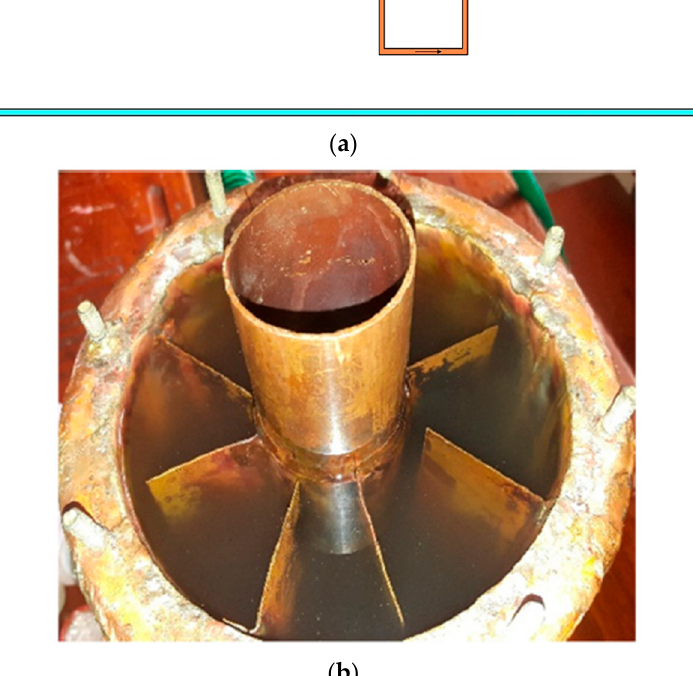
Table 4. Experimental conditions during the charging and discharging